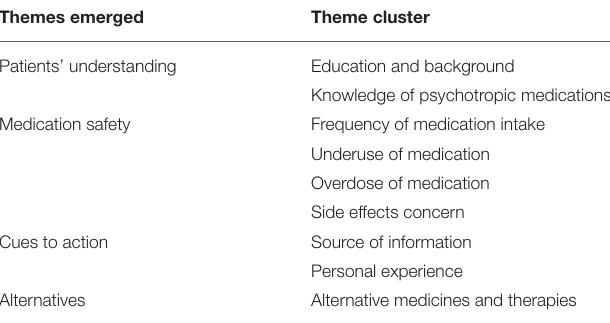
TABLE 1 | Data matrix of thematic analysis. Themes